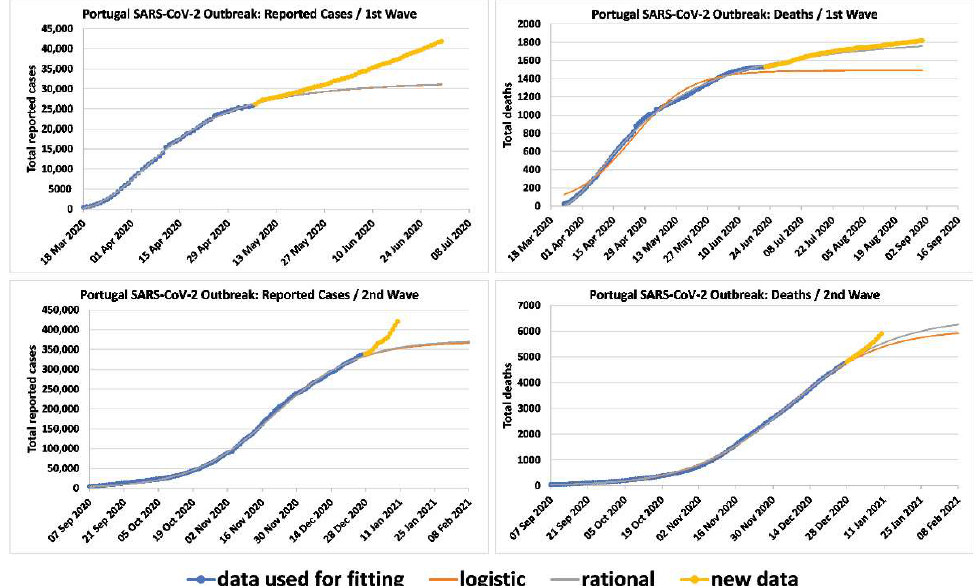
Figure 2. Comparisons between the actual reported cases and actual deaths for the first and second waves in Portugal vs. the fitted logistic and rational formulae. The data were fitted up to 27 December 2020, the last day before the first appearance of the UK lineage. The third wave in Portugal began